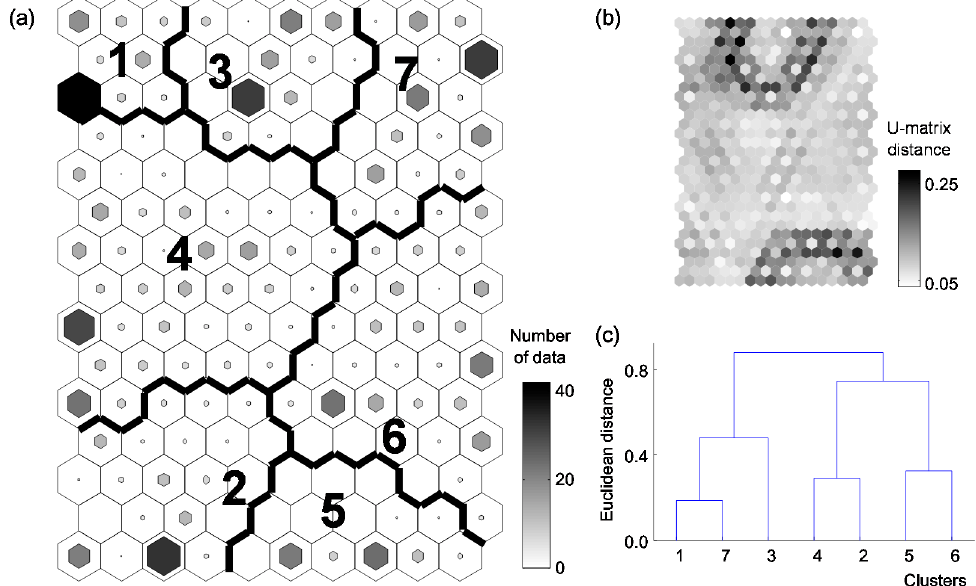
Figure 4. Patterning the behavioral differences in Pomacea canaliculata according to changes in water temperatures (from 25 ◦ C to 15 ◦ C, 20 ◦ C, 25 ◦ C, or 30 ◦ C). ( a ) Classification of apple snails in the self-organizing map (SOM) trained with nine behavioral categories; ( b ) U-matrix; and ( c ) dendrogram of a hierarchical cluster analysis of the SOM units using the Ward linkage method based on the Euclidean distance.